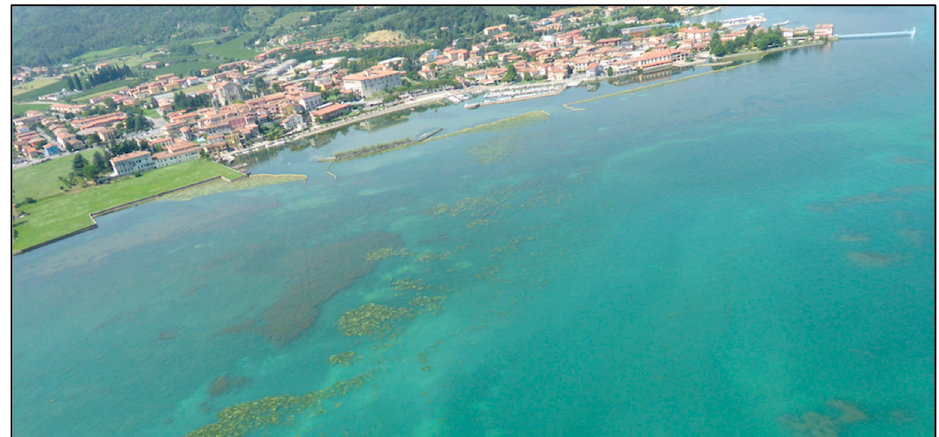
Figure 4. Aerial picture of the area in front of the Clusane harbor (5 August 2017, courtesy of A. Ziliani, Iseo).